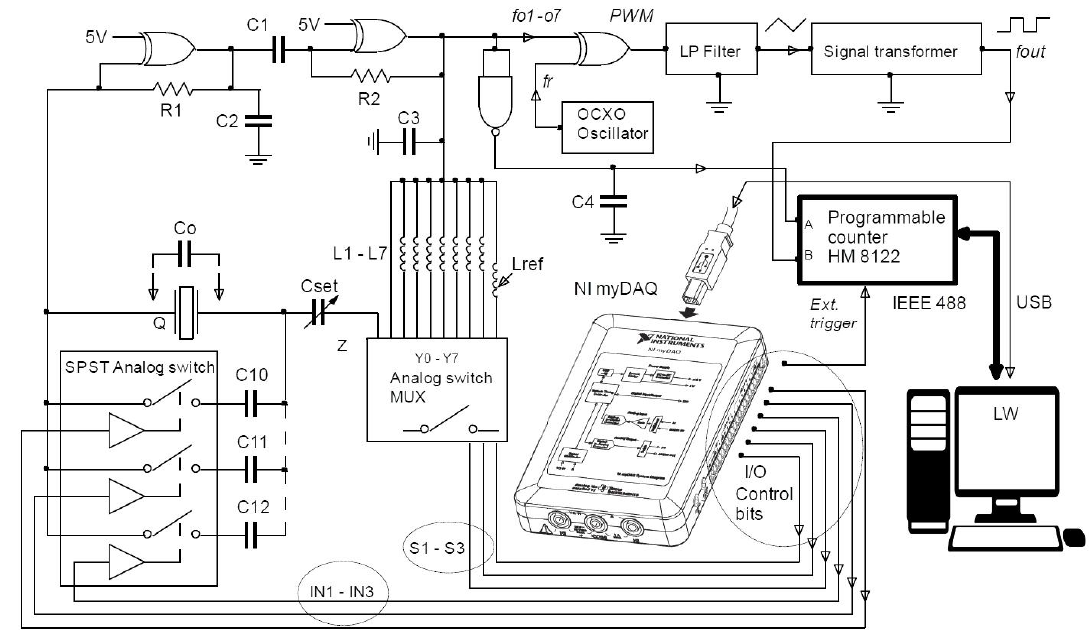
Figure 3. Schematic representation of the inductance-to-frequency converter hysteresis measurement.